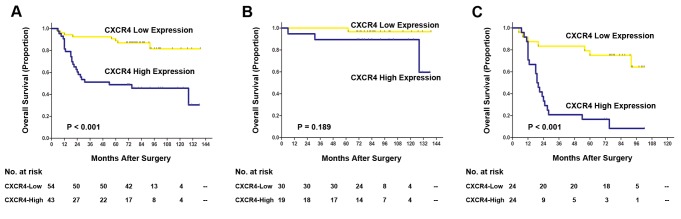
Analyses of overall survival according to the expression of intratumoral CXCR4 in gastric cancer patients.(A–C) Kaplan-Meier analyses of overall survival according to intratumoral CXCR4 expression in patients with gastric cancer in (A) all patients (n=97), (B) TNM stage i+ii (n=49), and (C) TNM stage iii+iv (n=48). P value was calculated by log-rank test.